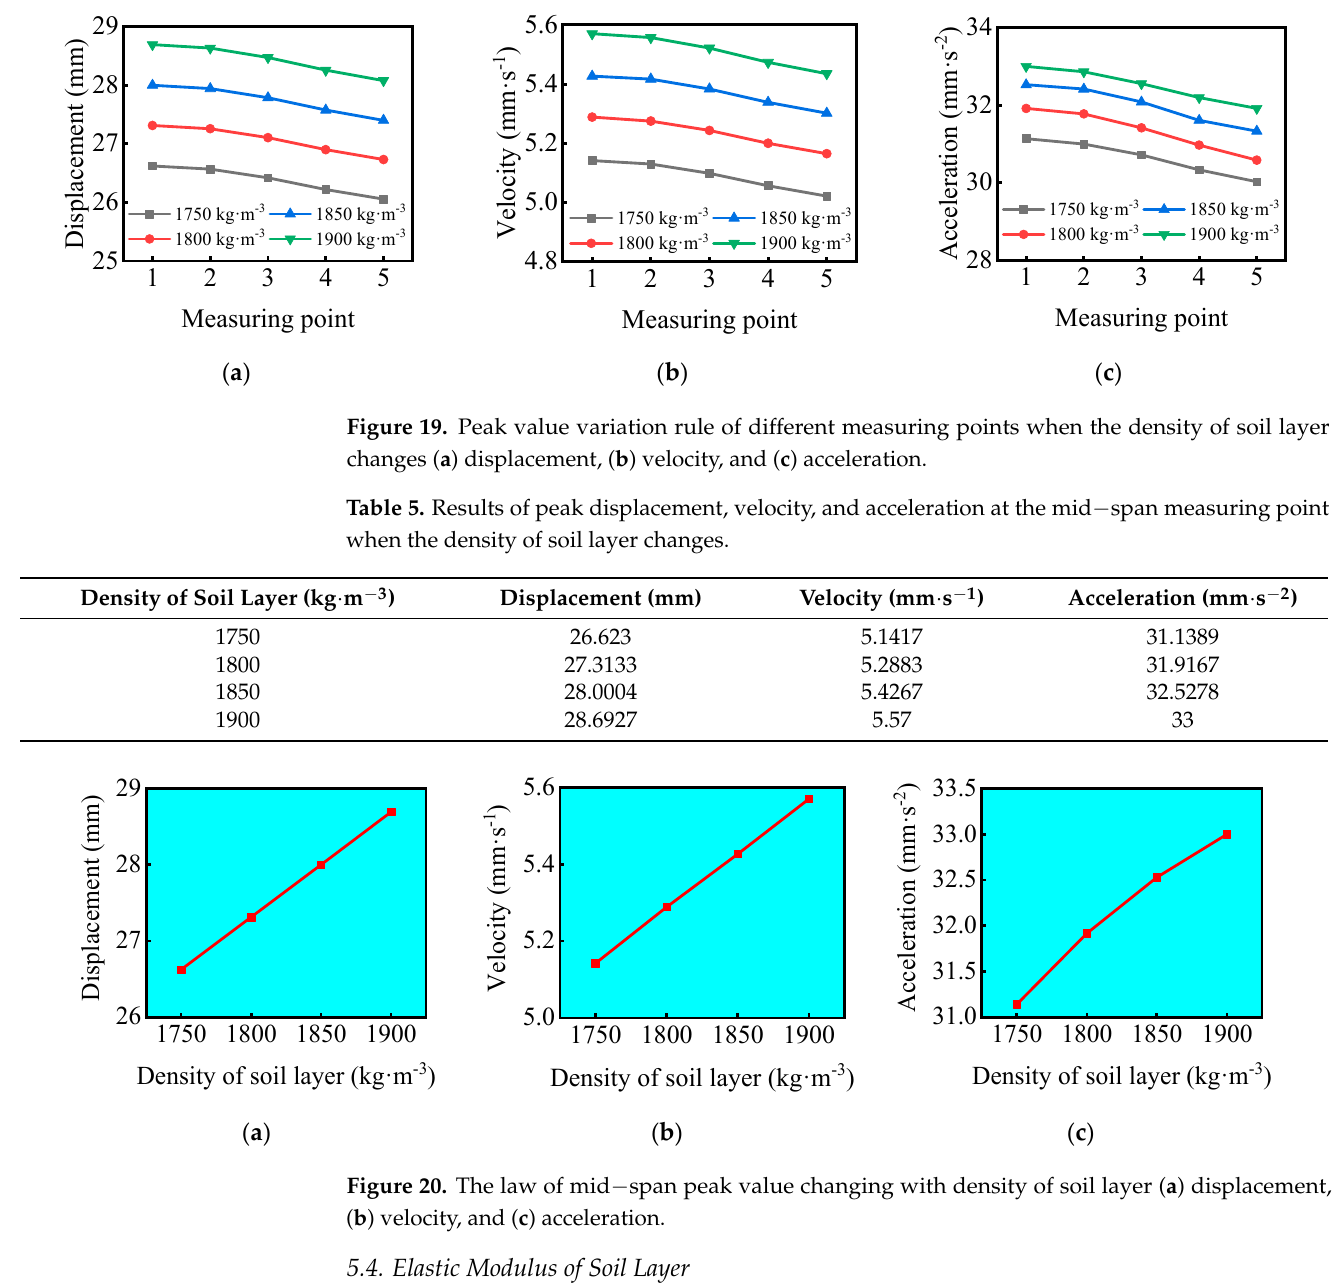
Table 5. Results of peak displacement, velocity, and acceleration at the mid − span measuring point when the density of soil layer changes.